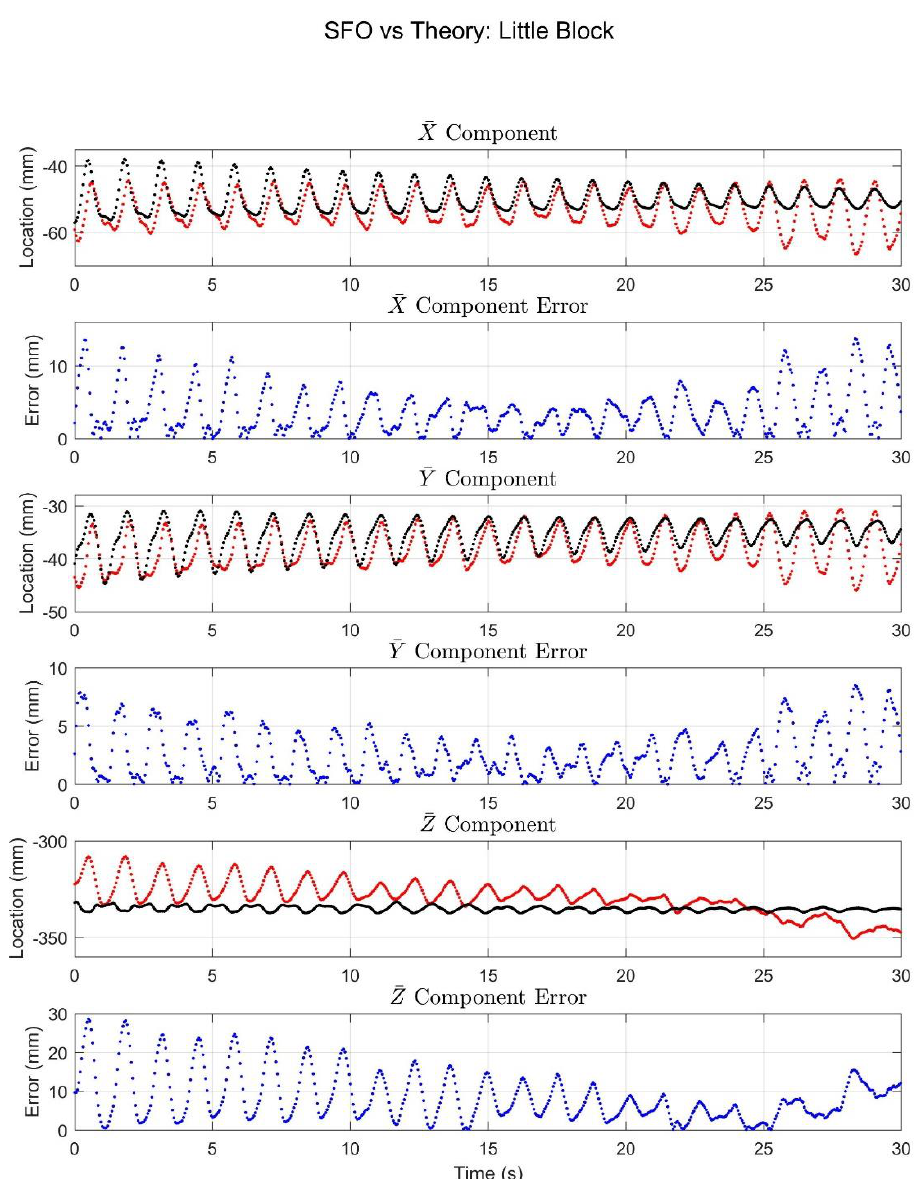
Figure 8. The results for the little block trial. The black and red (or light and dark) plots denote the marker and SFO joint center component solutions, respectively, in terms of 𝑋̅ , 𝑌̅ , and 𝑍̅ components. The error plots show the difference between the two solutions.